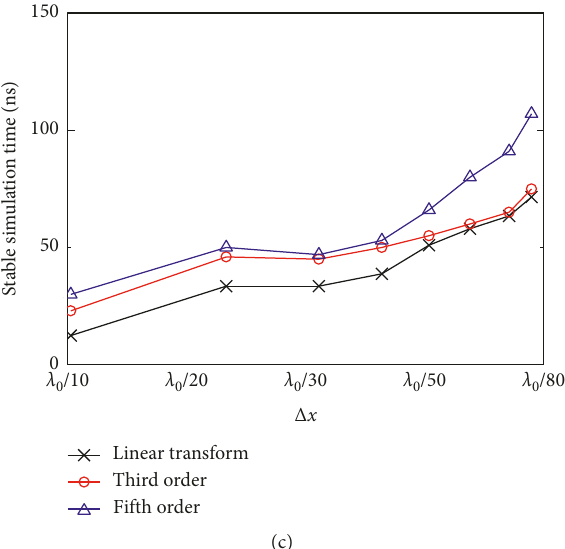
Figure 12: Stable simulation time: (a) the cloak, (b) the rotator, and (c) the concentrator. The stable time was increased as the error was